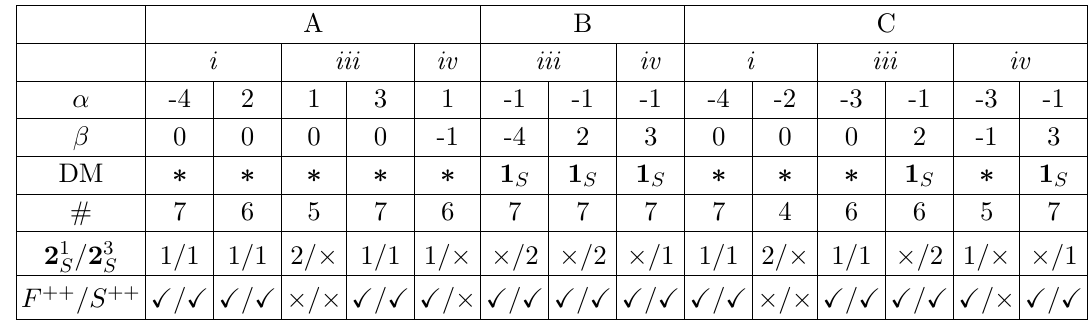
Table 14. The same as in table 10 for diagram 2.e of (cid:12)gure 2.